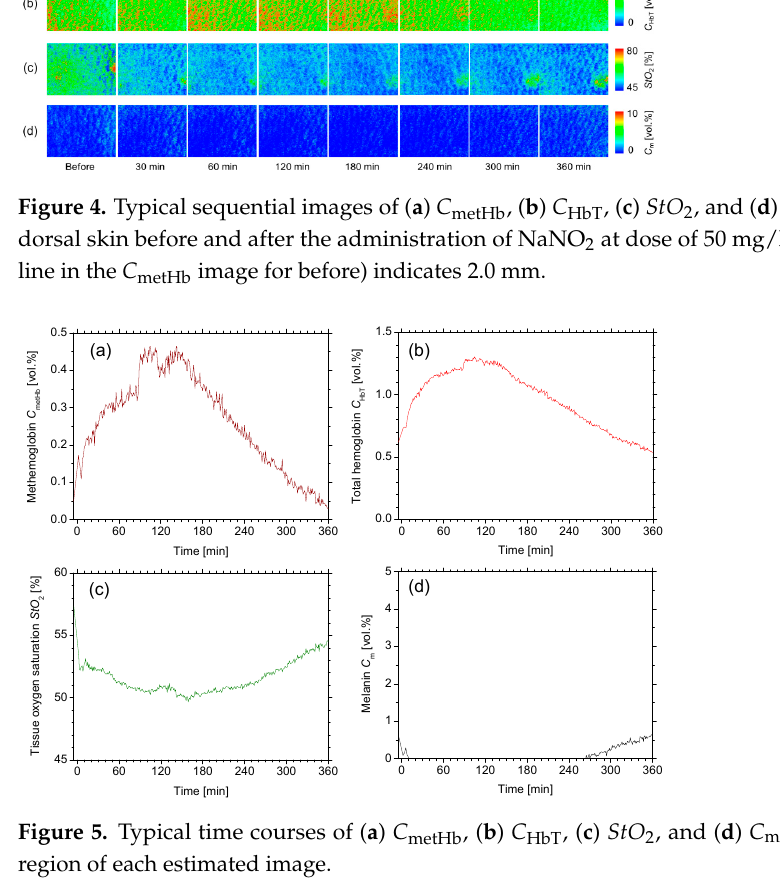
Figure 5. Typical time courses of ( a ) C metHb , ( b ) C HbT , ( c ) StO 2 , and ( d ) C m averaged over entire region of each estimated image.